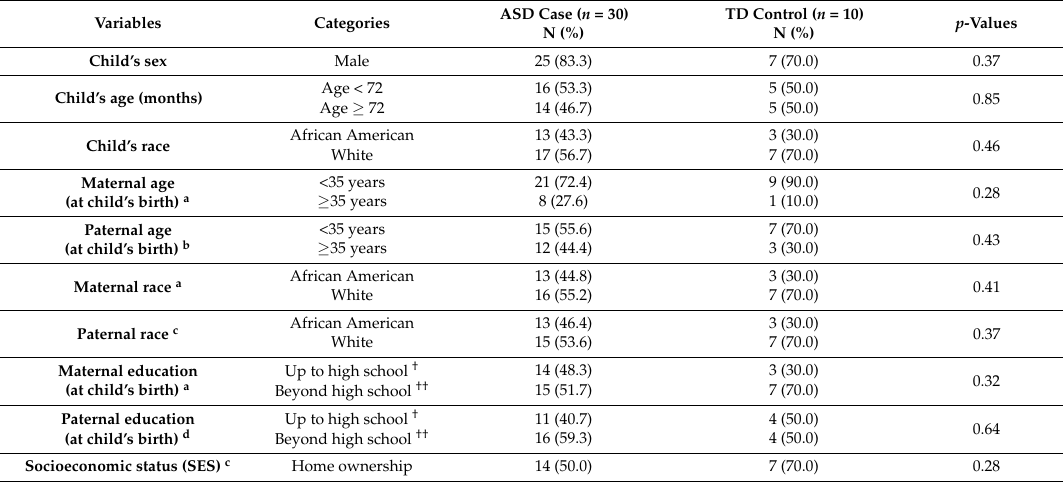
a Data were missing for 1 ASD case, b Data were missing for 3 ASD cases, c Data were missing for 2 ASD cases, d Data were missing for 3 ASD cases and 2 TD controls, † Up to high school education means attended Primary/Jr. Secondary, and Secondary/High/Technical schools, †† Beyond high school education means attended a Vocational, Tertiary College, or